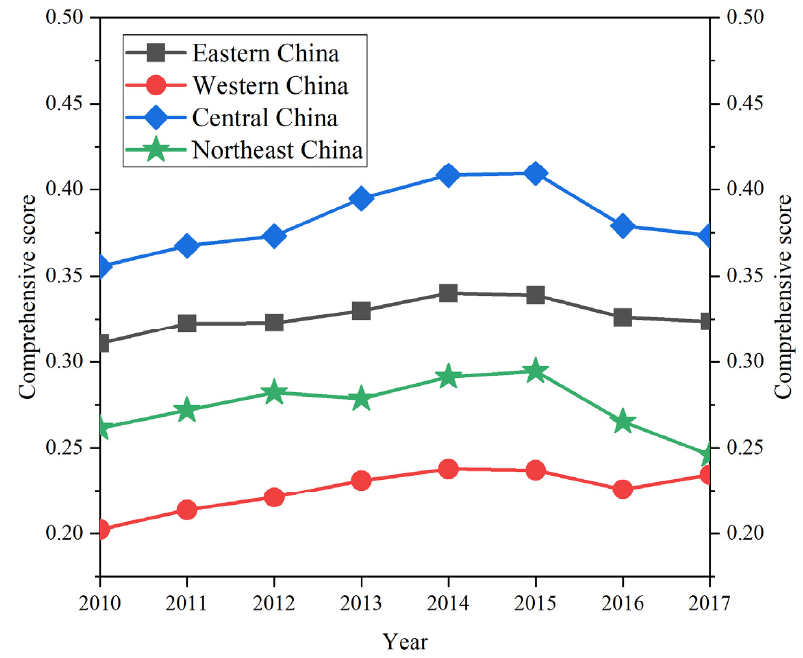
Figure 3. Temporal variation of ecosystem service demand in China from 2010 to 2017.